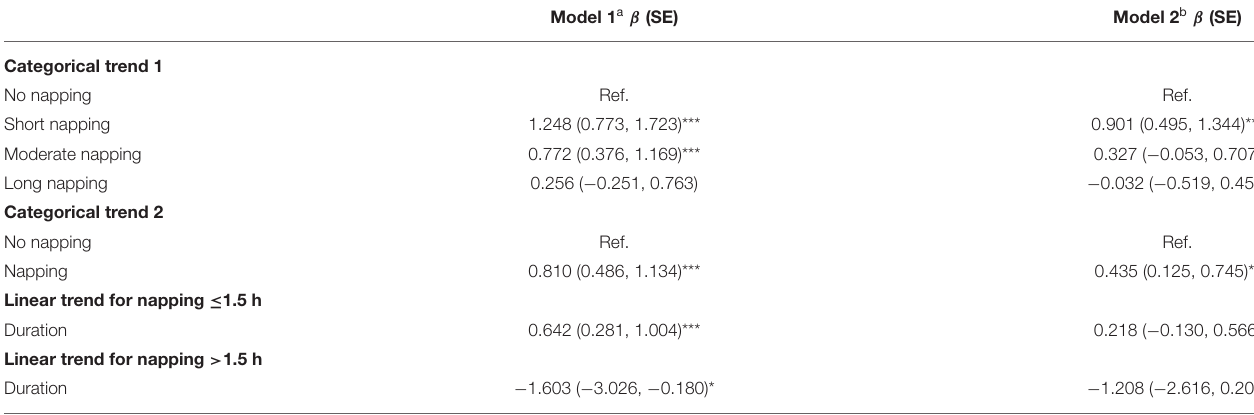
TABLE 2 | Associations between baseline daytime napping and longitudinal cognitive function according to generalized estimating equations